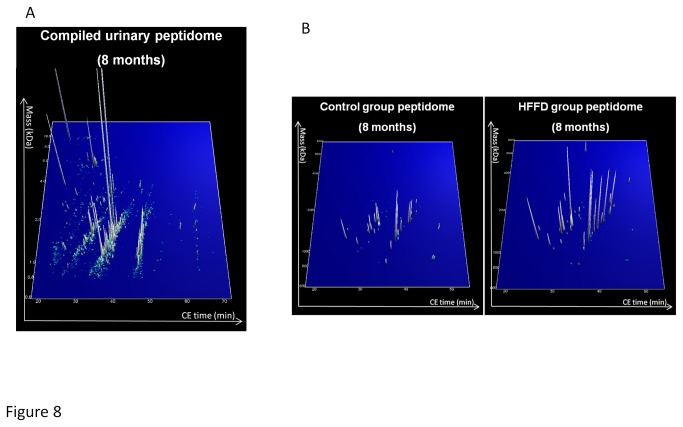
Comparison of the urinary peptidome content between control (n=10) and HFFD (n=11) at 8 months of age mice.(A) A contour plot representing the compiled urinary peptidome of all HFFD mice showing 2687 urinary peptides. Each blue to white colored dot or peak represents a urinary peptide identified by a specific mass (kDa) and migration time on the CE (min). When a peptide is detected but of low abundance it is represented by a blue dot. Increasing abundance of peptide is represented by a change of color towards white. At the same time the abundance is given by the height of the peak. Therefore a dot equals low abundance and a peak equals higher abundance, with the height of the peak being the relative abundance compared to the other peptides. (B) Representation of the 62 peptides which differ in urinary abundance between control and HFFD fed mice. In panel B, the scale was amplified 2-fold to improve the representation of the peptides.